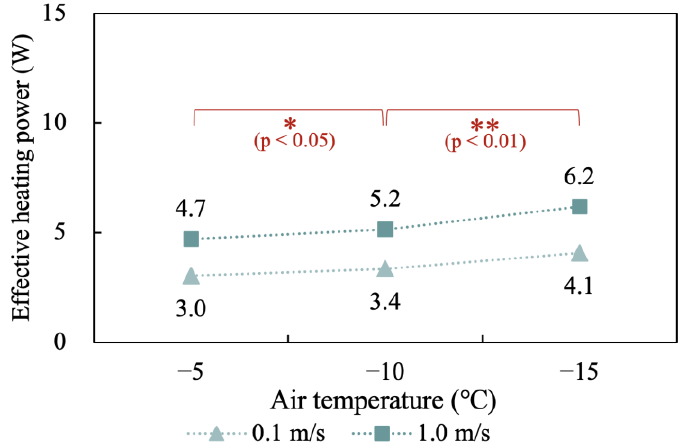
Figure 13. P eff of CHI in different experimental conditions.